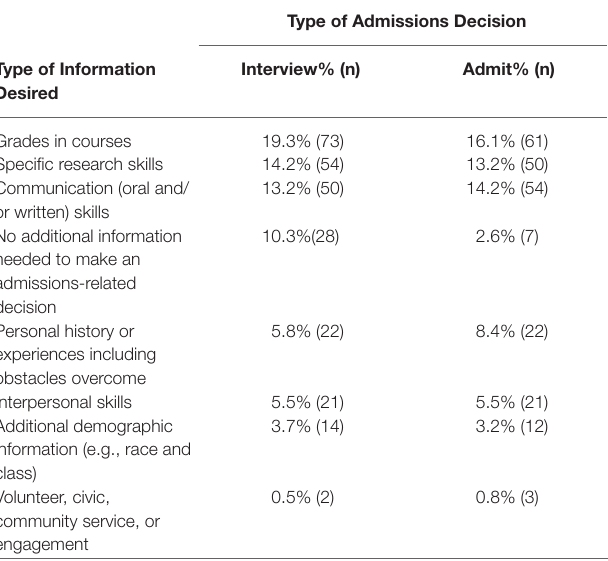
TABLE 3 | Desired information before making an admissions-related